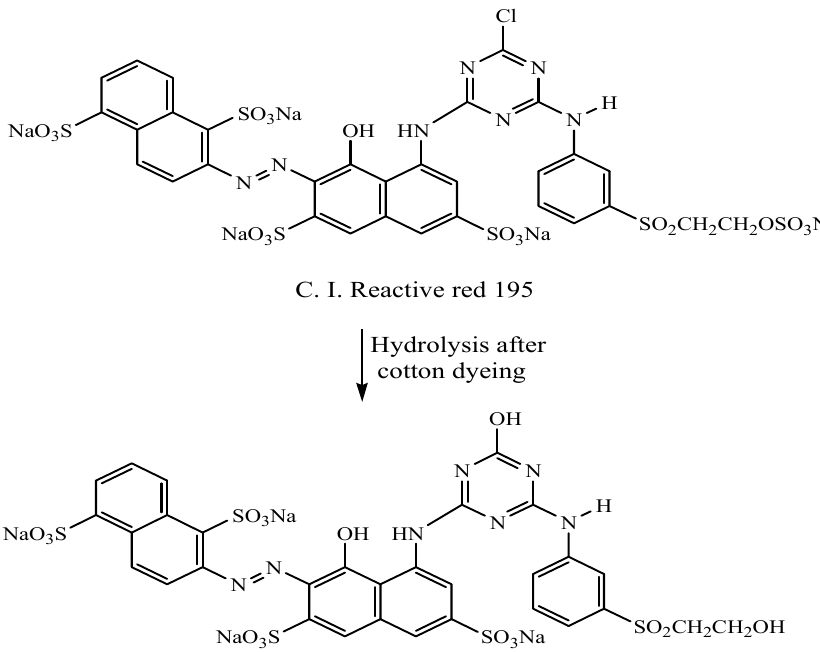
Figure 1. C.I. Reactive red 195 and hydrolyzed reactive red 195. Table 2. Color strengths of fabrics dyed with reactive red 195.